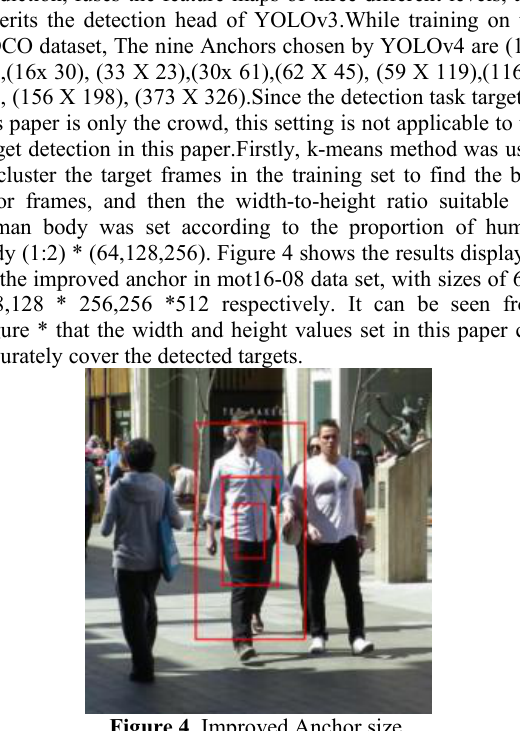
Figure 4 . Improved Anchor